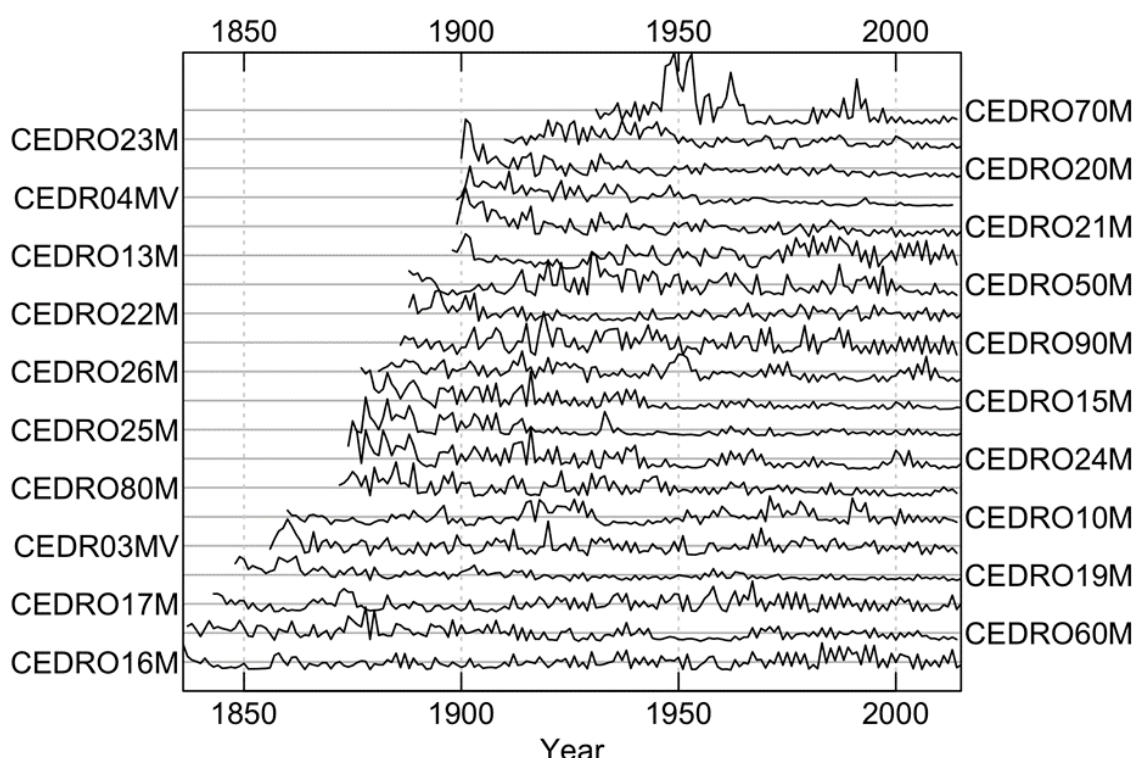
Figure 4. Tree-ring series of the 20 samples.